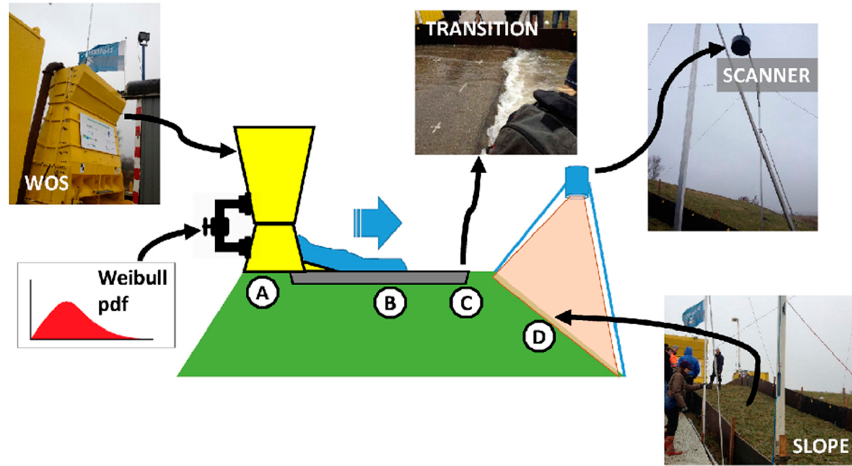
Figure 2. Millingen wave overtopping simulator (WOS) experiment with a road on top of the crest. Volumes released by the WOS are obtained from random sampling list from a fitted Weibull distribution.